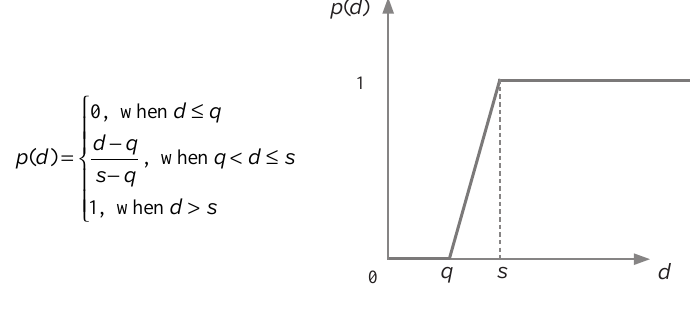
Fig. 5. V-shape with indifference preference function and its graph